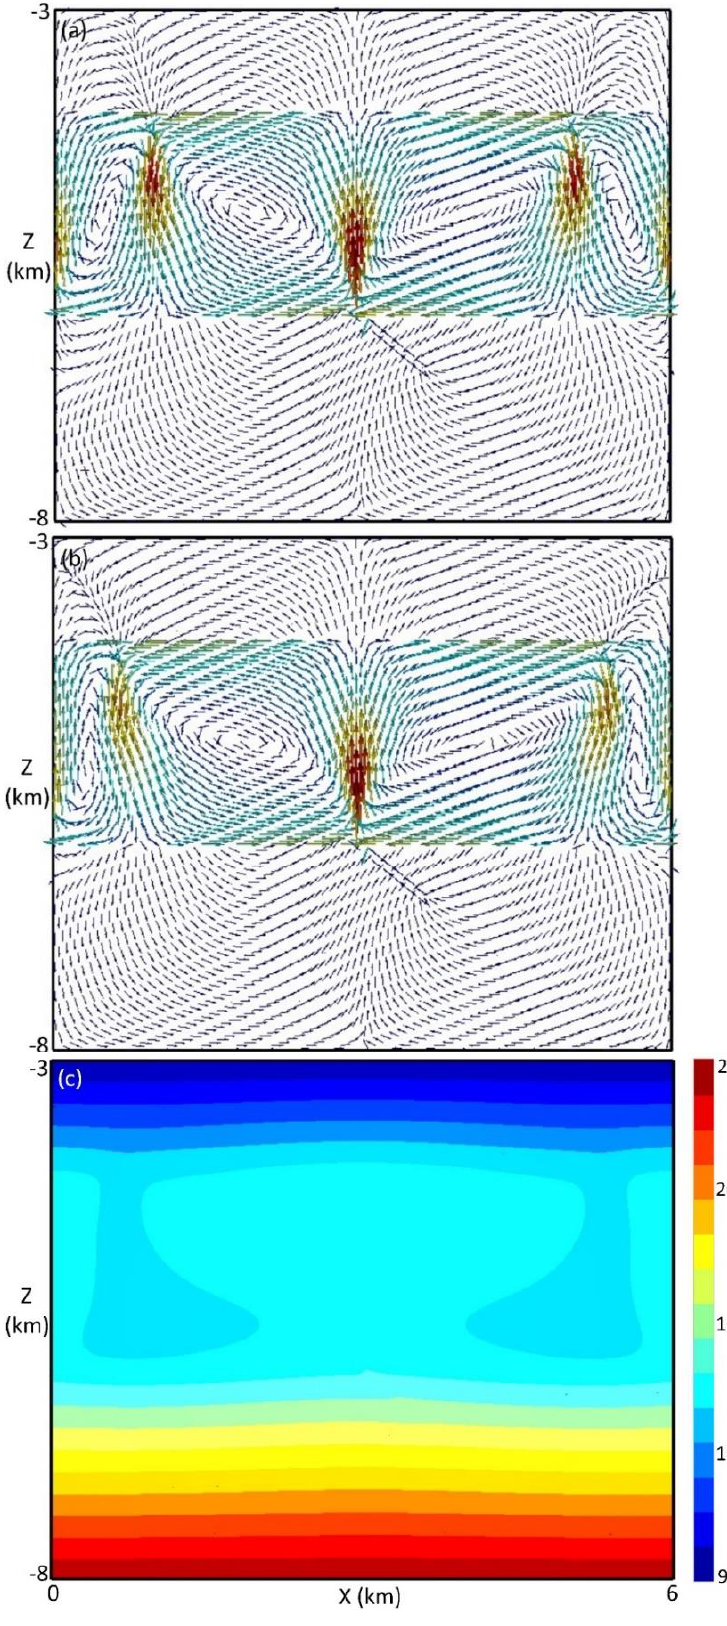
Figure 3. Numerical results for Scenario 1: ( a ) the flow vectors at 50,000 years, ( b ) the flow vectors at 300,000 years, and ( c ) the temperature distribution at 300,000 years.